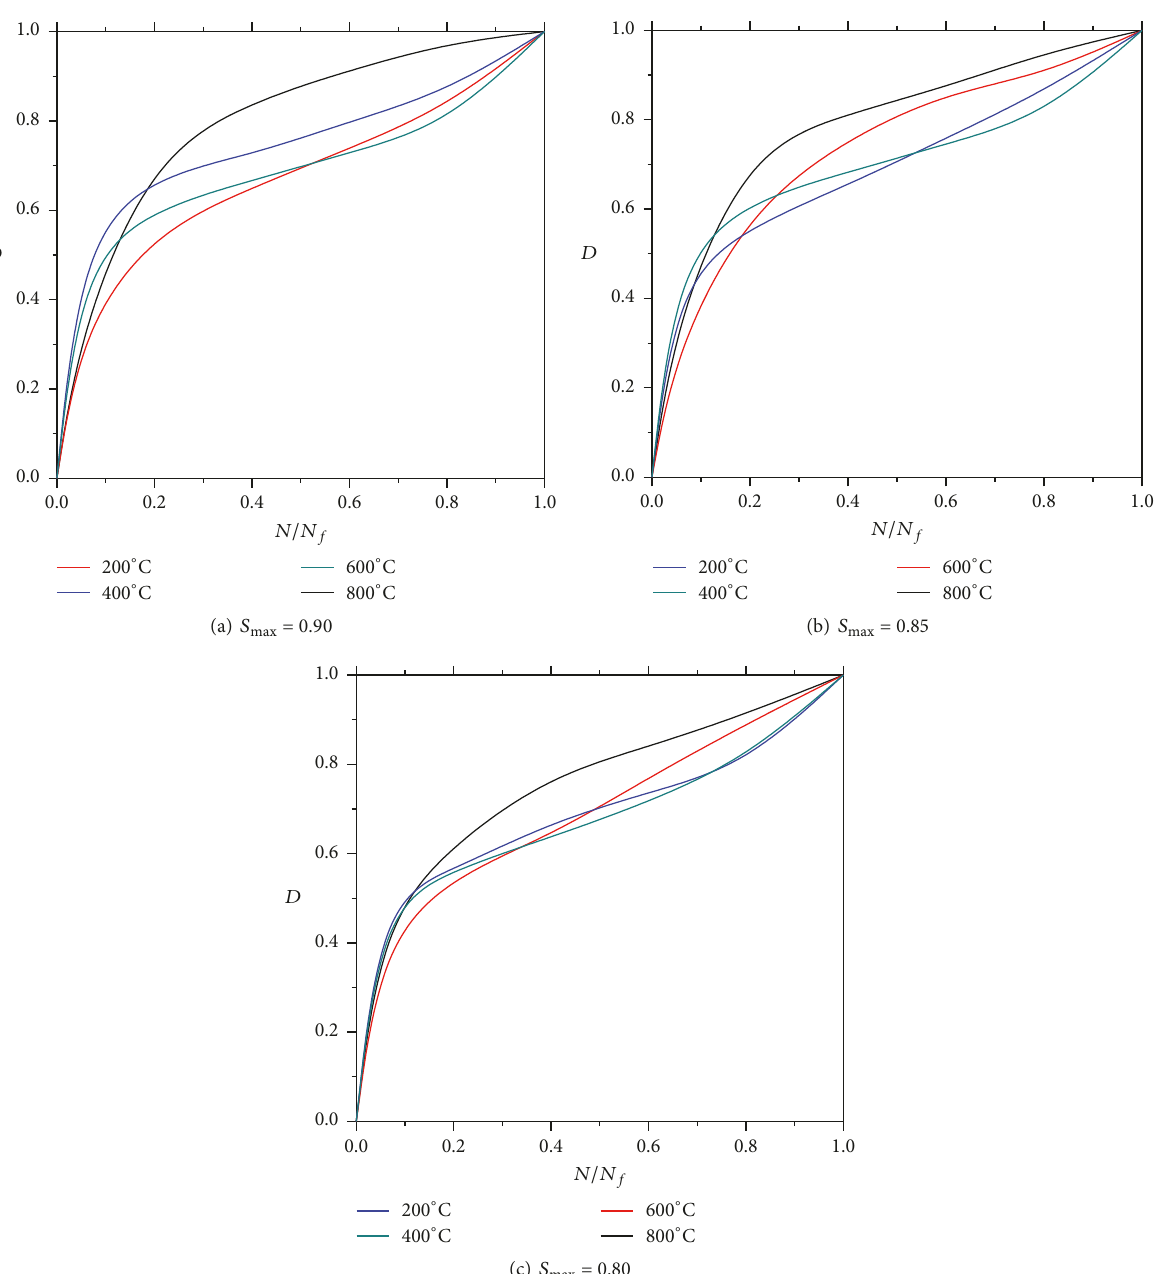
Figure 6: Relationship between damage and relative fatigue cycles of HSC with high temperature